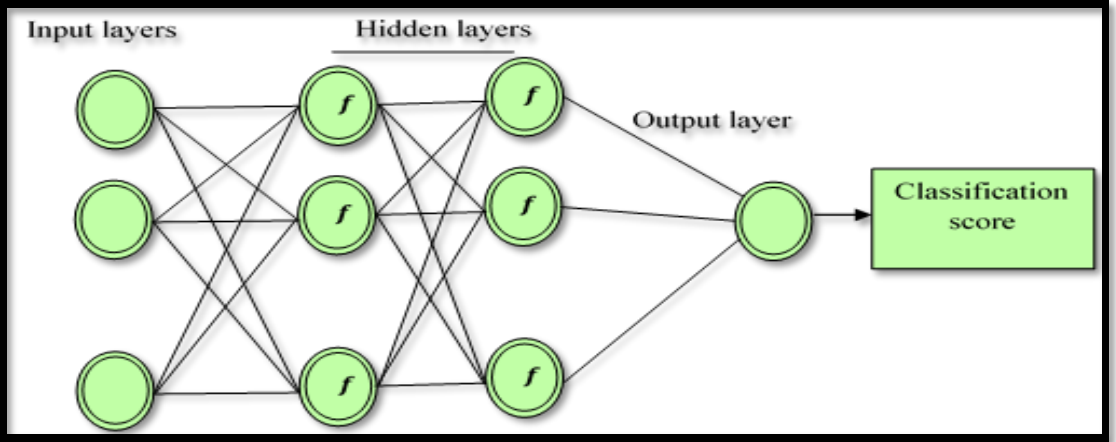
Figure 3. The structure of the newly proposed AdaBoost Back-Propagation neural network (AB_BP_NN) model applied for EEG signal classification purposes and subsequent epileptic disease identification.